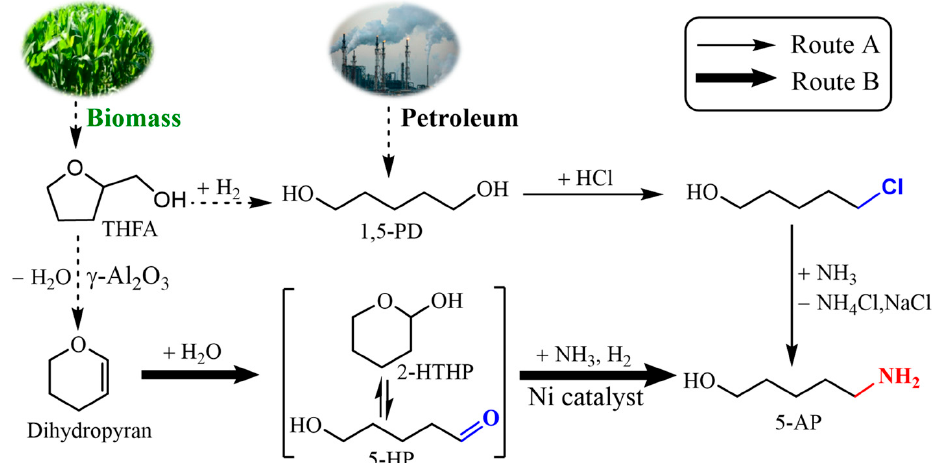
Figure 5. The synthesis of 5-AP from different routes. Adapted with permission from ref. [73]. Copyright 2021 Royal Society of Chemistry.